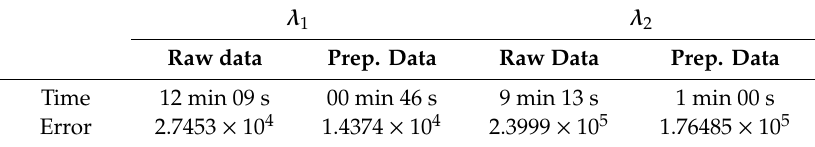
Table 2. The training results of raw data vs. preprocessed (prep.) data.